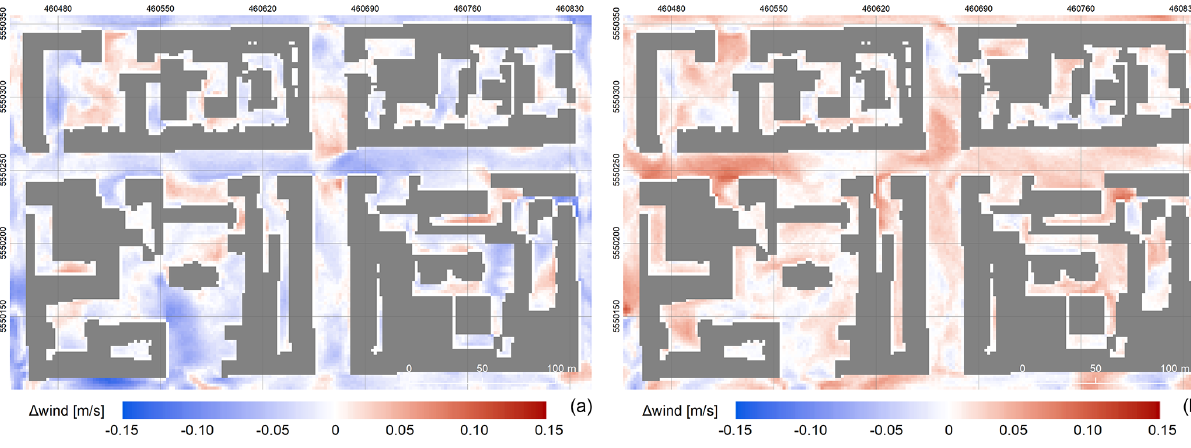
Figure 4. Daily average sensitivity of horizontal wind speed (1m) expressed as the difference between scenario and baseline. (a) Scenario SA01 (albedo increased by 20%); (b) scenario SA02 (albedo decreased by 20%). Projection: WGS 84 / UTM zone 33N; layer with roofs is own data